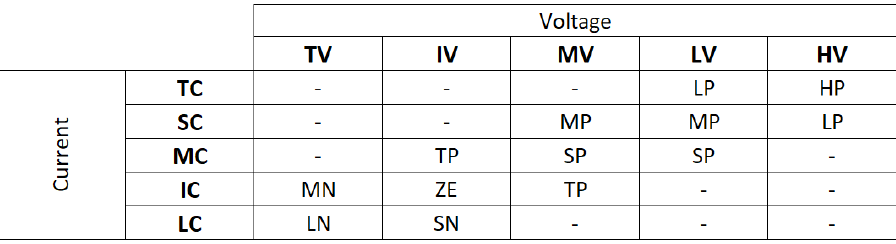
Figure 8. Fuzzy rule base of the proposed